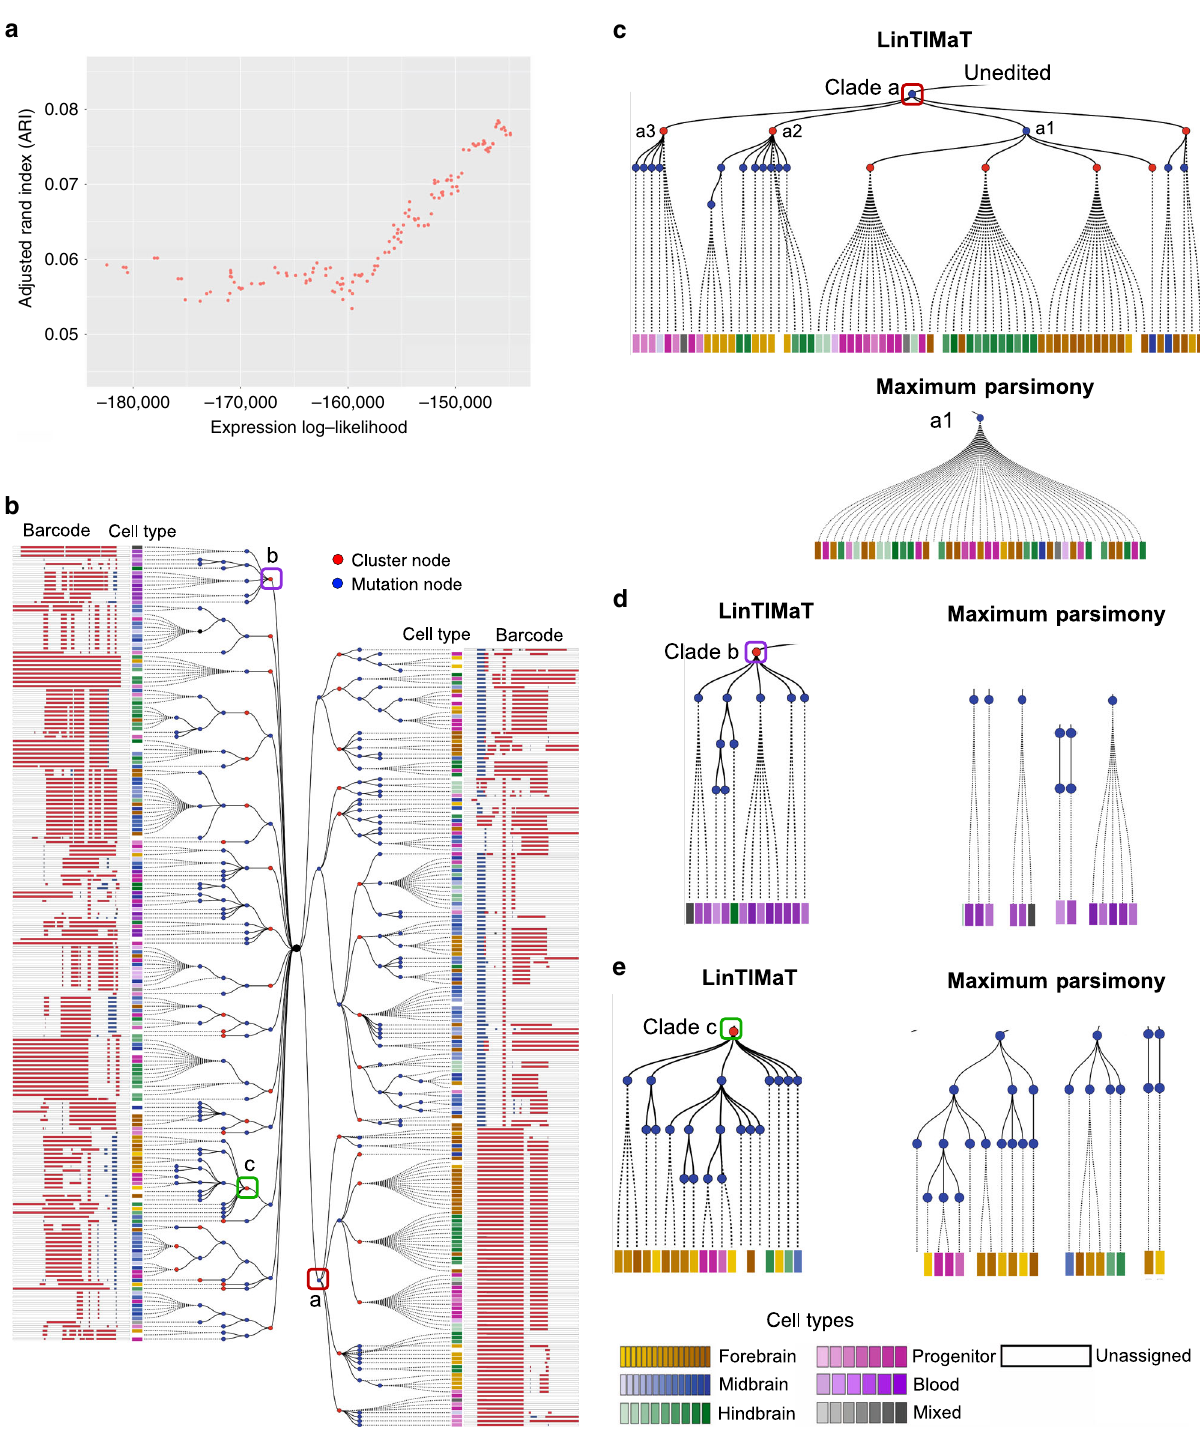
Fig. 3 Reconstructed cell lineage for a single juvenile zebra fi sh brain (ZF3) from scGESTALT dataset. a Adjusted Rand Index (ARI) which measures the agreement between cell types in the tree clusters and cell types assigned by the original paper 20 as a function of the likelihood computed by LinTIMaT. The fact that as the likelihood increases the ARI increases as well indicates that the target function of LinTIMaT is capturing biologically relevant relationships between cells. b Reconstructed cell lineage tree for ZF3 built on 376 cells. Blue nodes represent Cas9-editing events (mutations) and red nodes represent clusters inferred from transcriptomic data. Each leaf node is a cell, represented by a square, and its color represents its assigned cell type as indicated in the legend. The mutated barcode for each cell is displayed as a white bar with insertions (blue) and deletions (red). c By using transcriptomic data LinTIMaT is able to further re fi ne subtrees in which all cells share the same barcode, which can help overcome saturation issues. d , e Example subtrees displaying LinTIMaT ’ s ability to cluster cells with different barcodes together based on their cell types. In contrast, maximum parsimony puts these on distinct